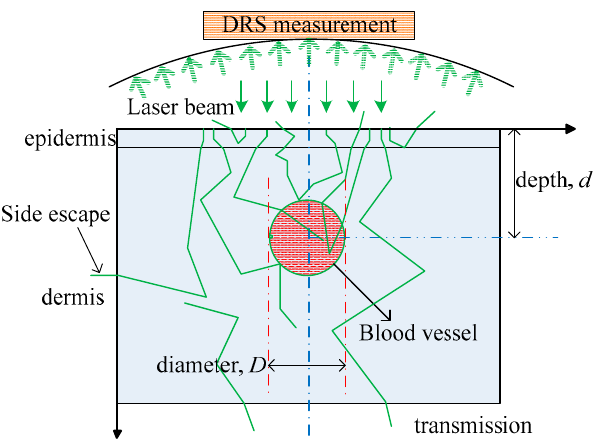
Figure 6. Schematic of DRS measurement.